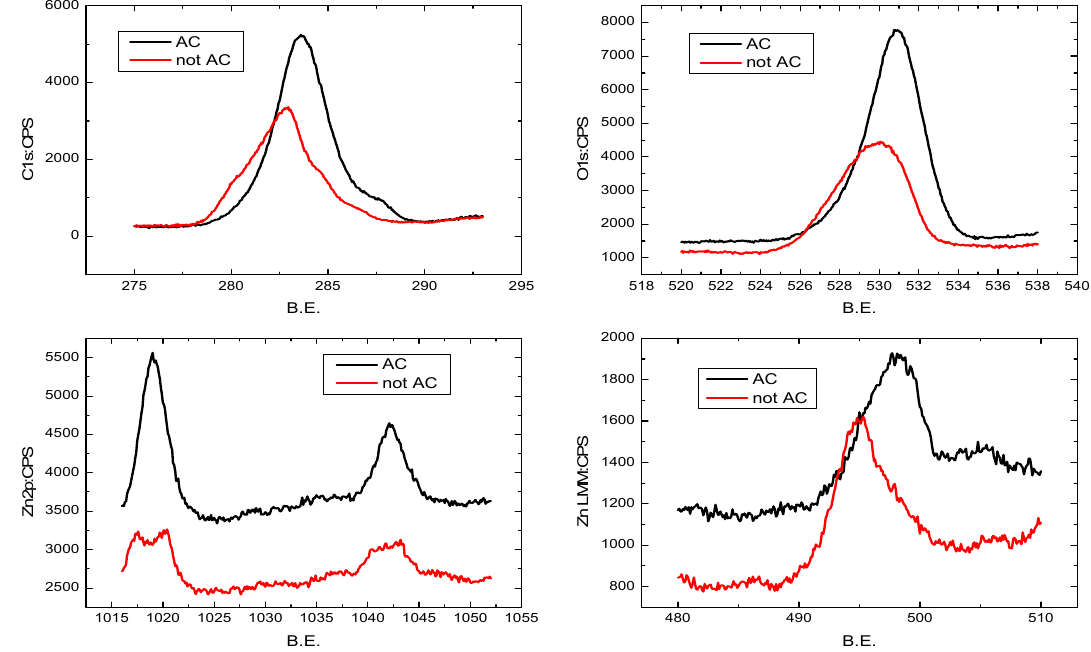
Figure 2. Spectra of C1S, O 1s, Zn 2p and Zn LMM of various morphologies of L.C + 4% Zn 2 +